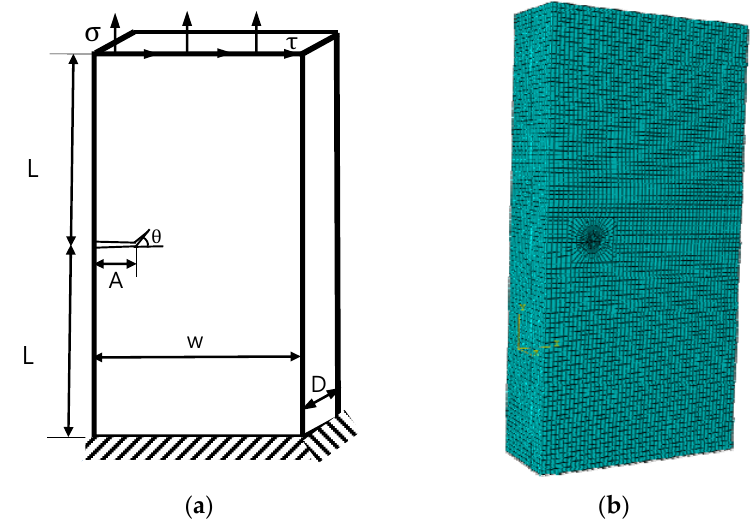
Figure 15. Crack model with mixed mode I-II-III in ABAQUS. ( a ) A 3 D model with a mixed ‐ crack; ( b ) The finite element model.